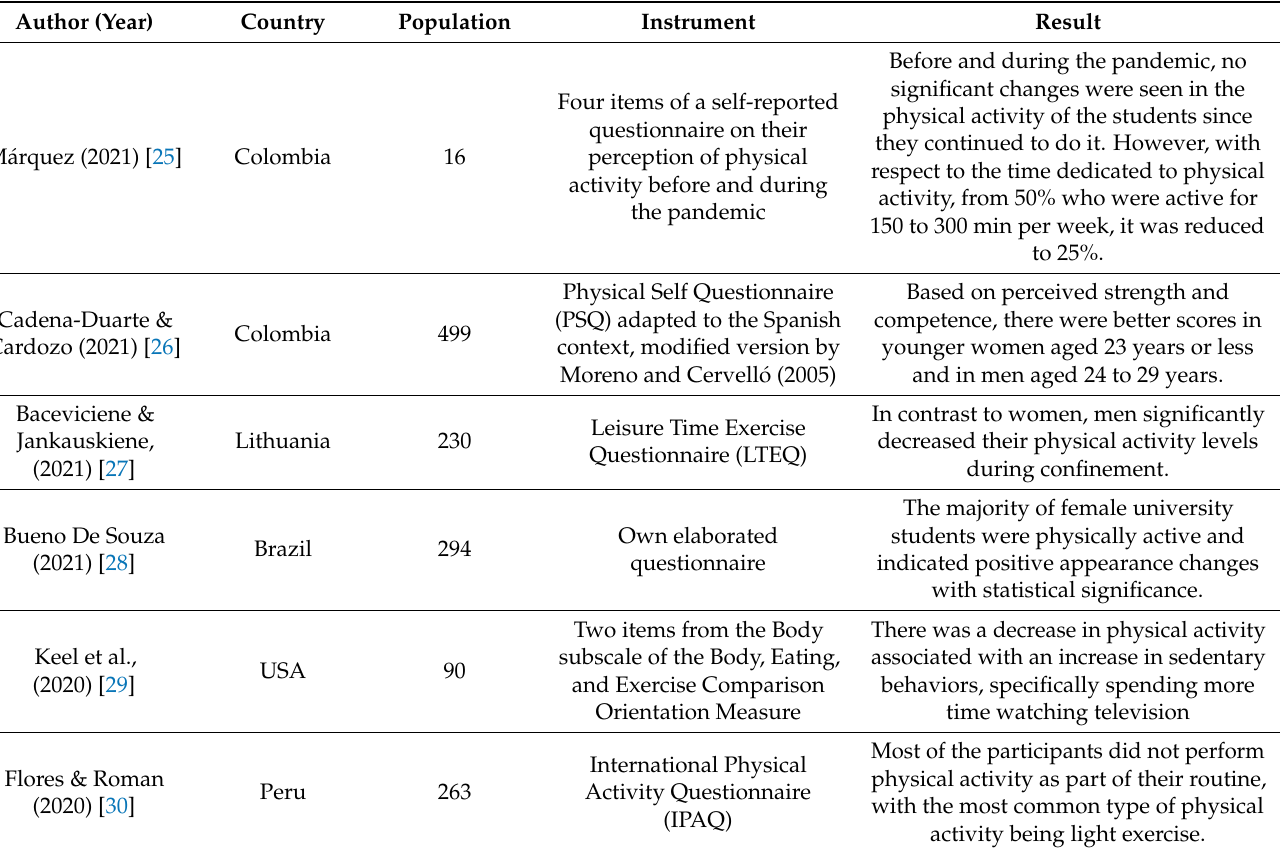
Table 2. Physical Activity in university students during the COVID-19